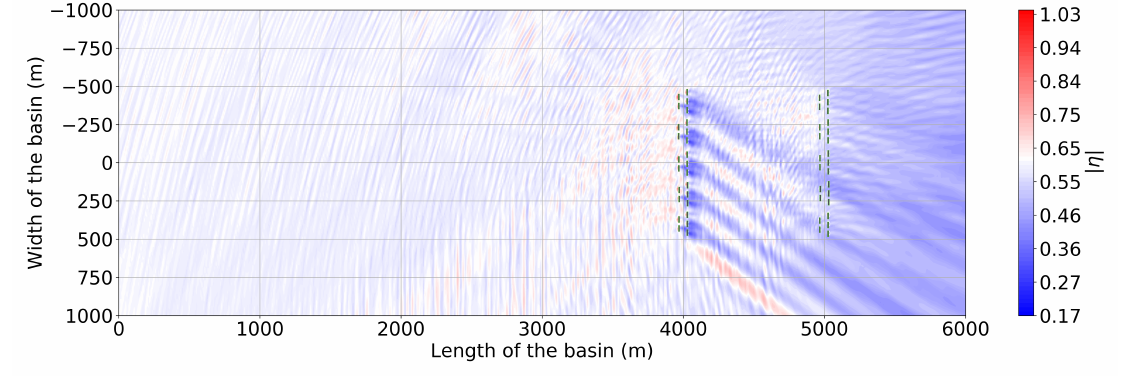
Figure 16. Coupled total | η | for the mean summer wave H m 0 = 1.20 m, T p = 8.71 s, and β = − 30 ◦ for a 50 WEC 10-Array